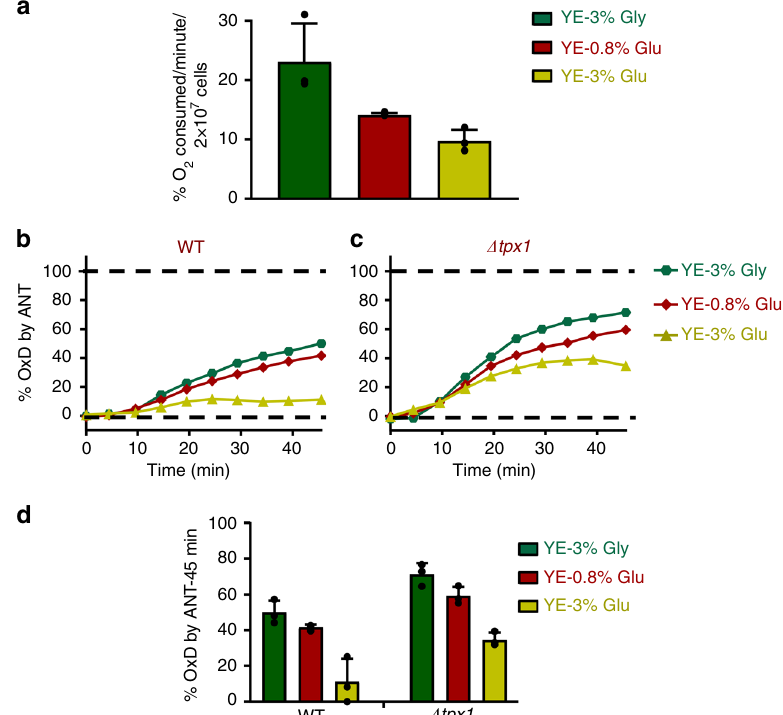
Fig. 7 roGFP2-Tpx1.C169S oxidation by ANT is proportional to mitochondrial activity. a Oxygen consumption of S. pombe cells grown in different growth media. Wild-type strain 972 was grown on YE media with 3% glycerol (YE-3% Gly), 0.08% glucose (YE-0.08% Glu), or 3% glucose (YE-3% Glu), and when cultures reached an OD 600 of 0.5 oxygen consumption was recorded (see Methods). Data from three biological replicates with error bars (S.D.) and individual data points overlaid (black dots) are shown. b , c Strains HM123 (WT) ( b ) and SG5 ( Δ tpx1 ) ( c ) transformed with plasmid p407.C169S were grown in YE media containing 3% glycerol (YE-3% Gly — green circles), 0.08% glucose (YE-0.08% Glu — red diamonds), or 3% glucose (YE-3% Glu — yellow triangles). At an OD 600 of 1, cells were transferred to fi ltered MM, and probe oxidation upon ANT treatment (5 µ M) was monitored for the times indicated. Ten minutes after addition of 1 mM H 2 O 2 was used to determine 100% probe oxidation in each strain and condition, while 0% was the starting OxD 0 for each strain and condition. Data from three biological replicates are shown, with error bars (S.D.) displayed in Supplementary Fig. 9bc. d roGFP2- Tpx1.C169S oxidation upon ANT treatment at 45 min from data of panels ( b ) and ( c ) is displayed. Data from three biological replicates with error bars (S. D.) and individual data points overlaid (black dots) are